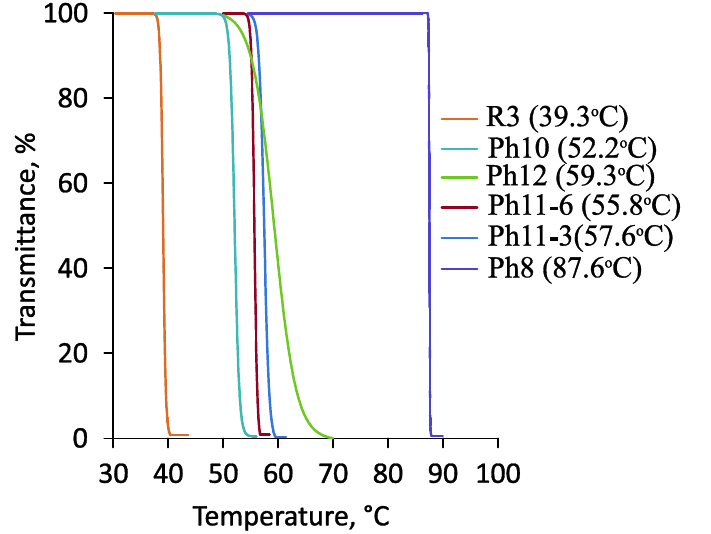
Figure 13. Light transmittance vs. temperature (heating cycle) for 1% aqueous solutions of samples Ph8, Ph10-Ph12 and R3.